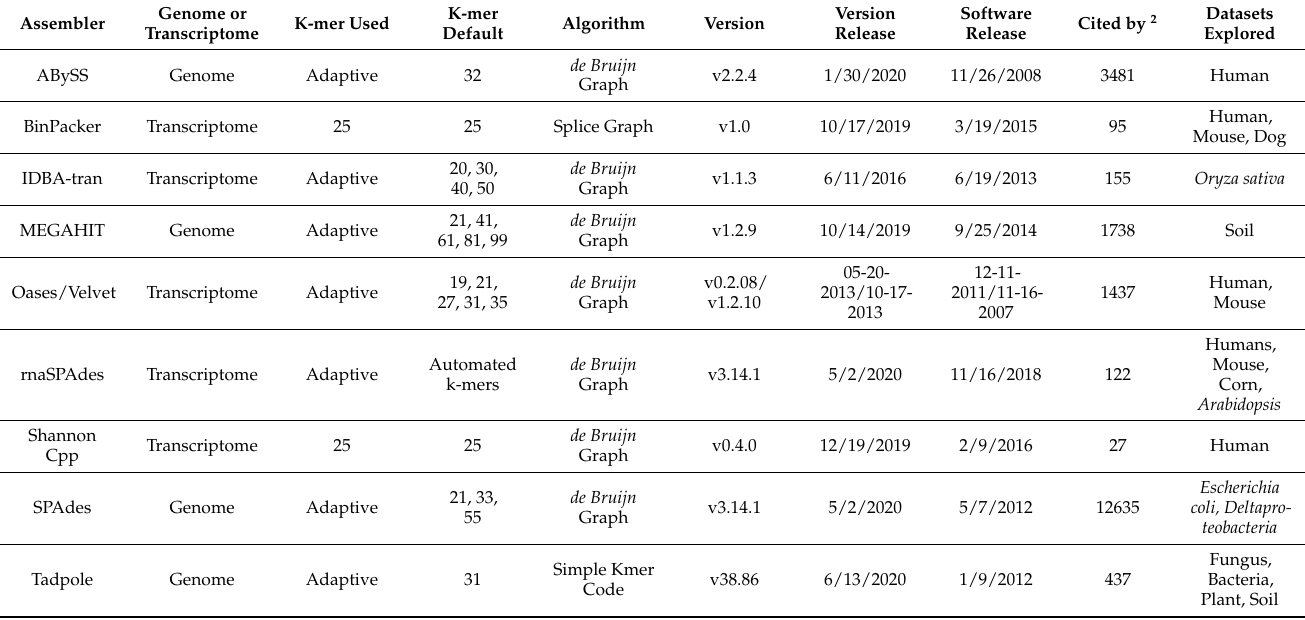
Table 1. De novo Assemblers Utilized in